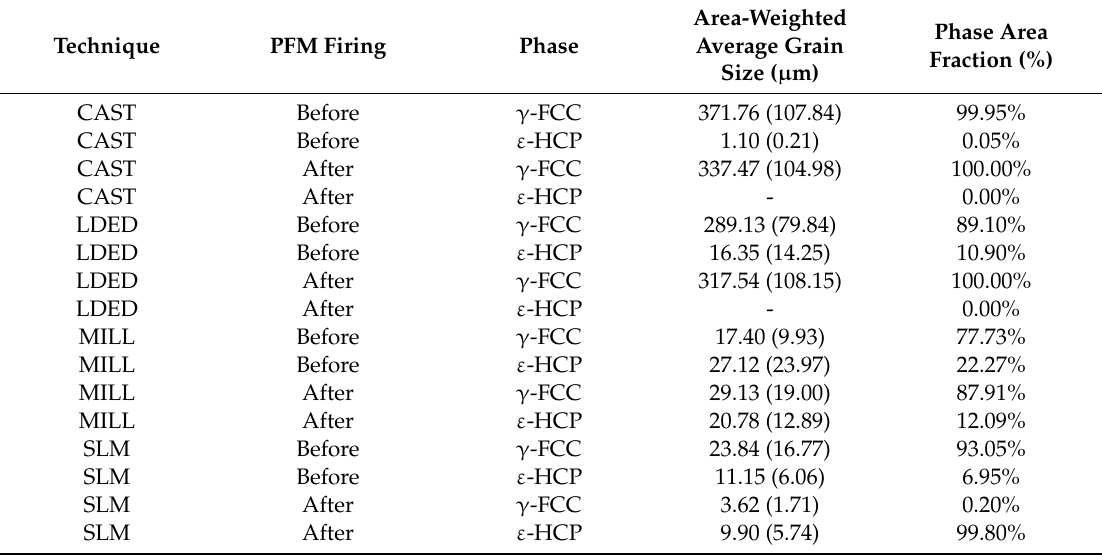
Table 4. Measured area-weighted average grain size and area fraction of the corresponding phases before and after PFM firing simulations of the indexed area in EBSD images. Standard deviation (SD) in